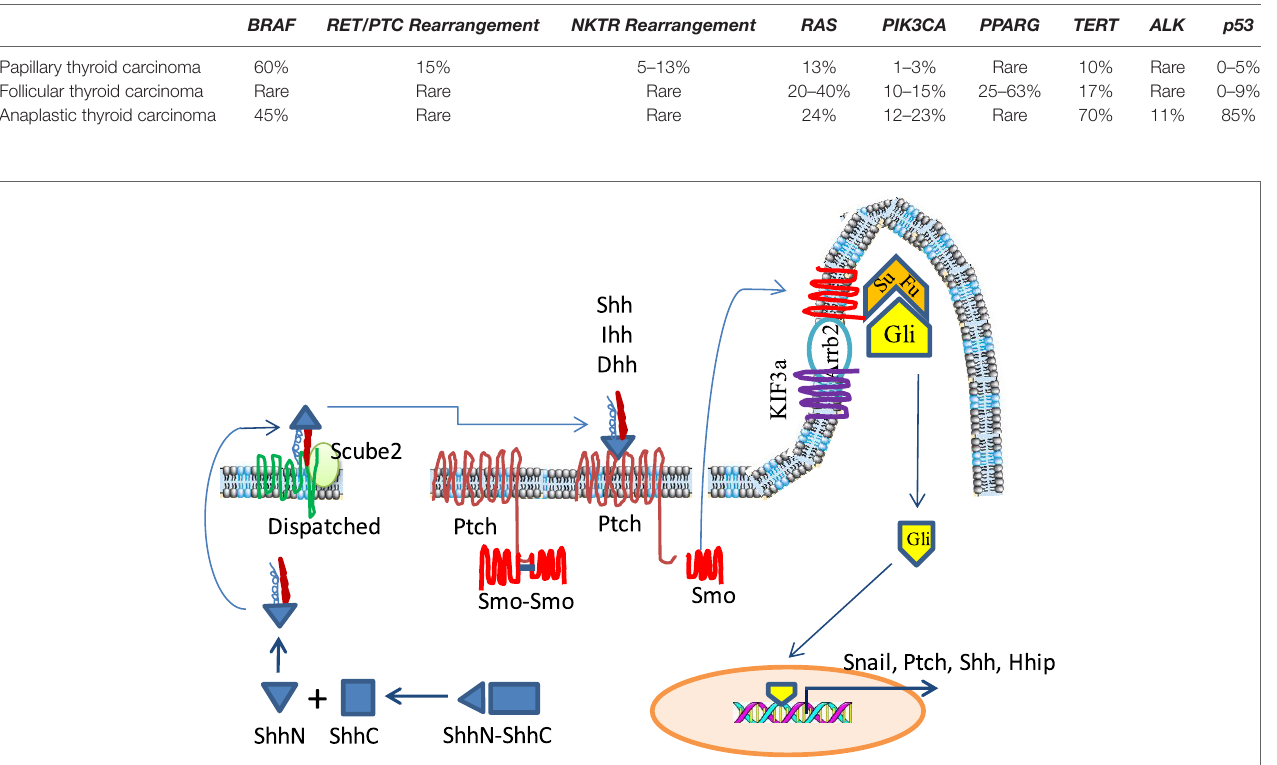
FiGURe 1 | The sonic hedgehog (Shh) signaling pathway in a mammalian system. Hedgehog (HH) ligand proteins are processed in the cytosol by autoproteolytical cleavage to generate an N-terminal subunit, which is further modified by the addition of palmitoyl and cholesterol moieties. The lipidated Shh is stored in the lipid-rich microdomain on the cell surface but is released by cooperative action of Dispatched and Scube 2. In the absence of ligand binding, Patched (Ptch) restrains Smoothened (Smo) in the cytosol and keeps it as an inactive dimer. Glioma-associated oncogene (Gli) is located at the ciliary tip where it interacts with and is repressed by Suppressor of fused (SuFu). Upon HH binding, Ptch releases Smo and allows it to translocate into the cytoplasmic membrane of the ciliary tip where it cooperates with KIF3a and Arrb2 to disrupt the interaction of SuFu and Gli. Freed Gli is then translocated into the nucleus to activate the transcription of its target genes such as Snail, Shh, and Ptch.